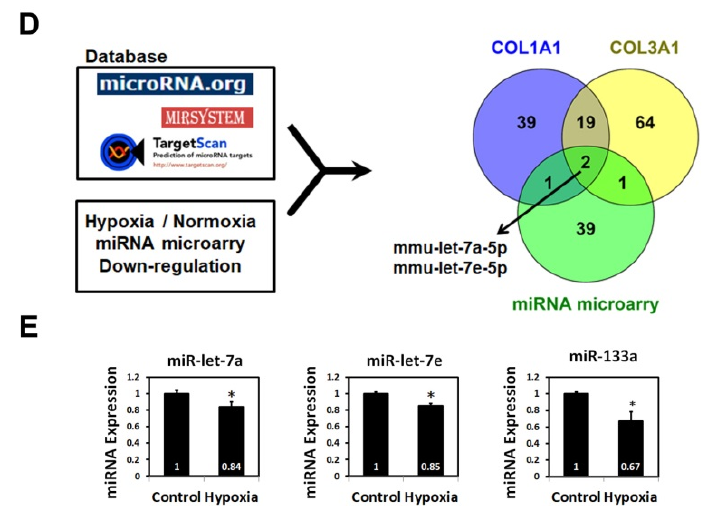
Figure 1. Differential expressions of proteins, mRNAs and microRNAs in hypoxic cardiomyocyte cells. ( A ) HL-1 cells were incubated under hypoxic conditions (1% O 2 ) for the indicated times. The indicated proteins were detected in cellular homogenates by Western blot analysis. ( B ) qRT-PCR analysis of fibrotic mRNAs was performed. Error bars represent means ± SD from three independent experiments. * p < 0.01 vs. normoxia; vs. hypoxia + scramble control mimic (NC), n ≥ 3. ( C ) Heat map showing the results of hierarchical clustering present the distinct microRNA expression profiles between hypoxia and controls. ( D ) Venn diagram showing the overlap between hypoxia-responsive microarray miRNAs or collagen-specific miRNAs in HL-1 cardiomyocytes under hypoxia stress. The three circles represent predicted miRNA target genes found in the list of reported miRNA